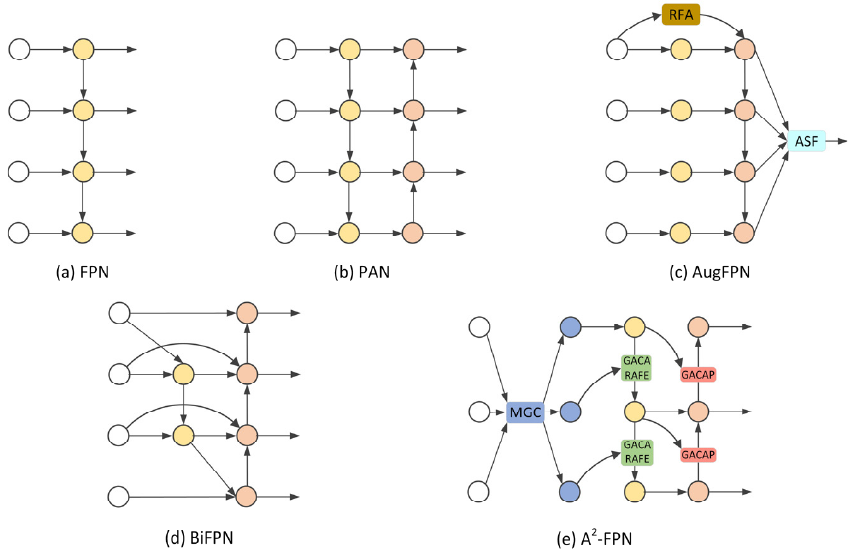
Figure 3. Feature Pyramid Network and its variants .